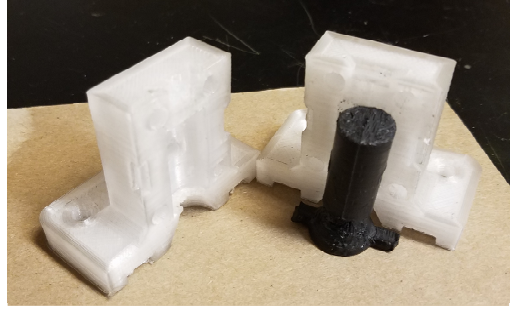
Figure 6. 3D-printed compression specimen mold with molded part.